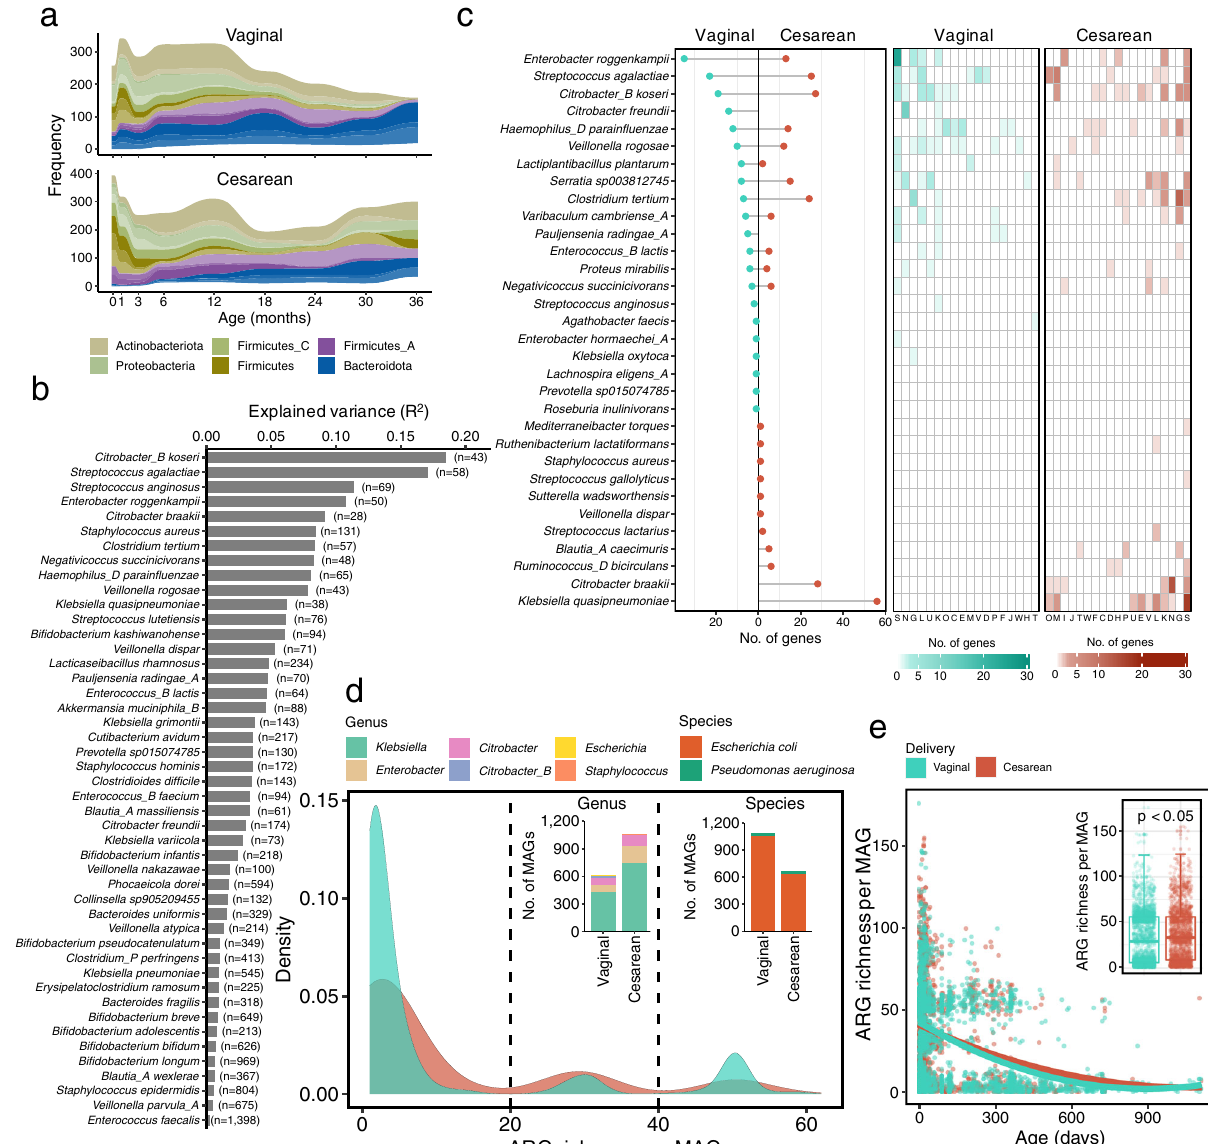
Fig. 5 | In fl uences of delivery mode on early-life gut microbiome at a genome- resolvedlevel.a Prevalenceof16bacterialgenerainchildrenstrati fi ed bydelivery mode over time, where each genus was colored by its phylum. Only genera with >10% prevalence in children born by any of delivery modes are plotted. b The explained variance (R 2 ) contributed by delivery mode of 46 species that were sig- ni fi cantly (PERMANOVA, FDR<0.05) associated with delivery mode based on the hamming distance of core genes per species. The number in parentheses indicate the number ofMAGs of this species. c The number of genes that were prevalent in C-sectionbornchildrenorvaginallybornchildren(>70%inC-sectionbornchildren and <30% in vaginally born children, and vice versa) for each species and their